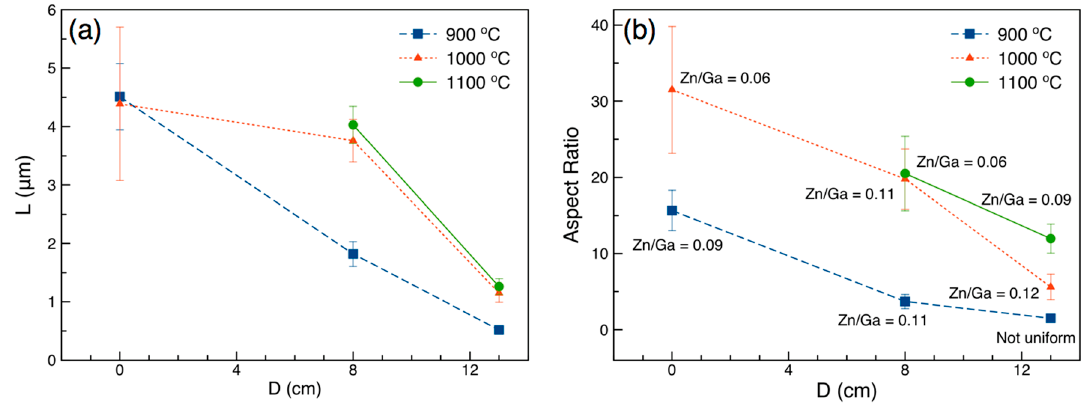
Figure 4. Dimensions of synthesized GaN:ZnO nanowires. ( a ) Length and ( b ) aspect ratios of the nanowires prepared at various source temperatures, set to 900 °C to 1100 °C, and locations (D) downstream of the Ga 2 O 3 and ZnO source materials. Error bars represent a 90% confidence interval. Uniform coverage was not realized at T s = 900 °C for 60 min at D = 13 cm; thus, the results are presented based on a few available nanowires observed in the study region.